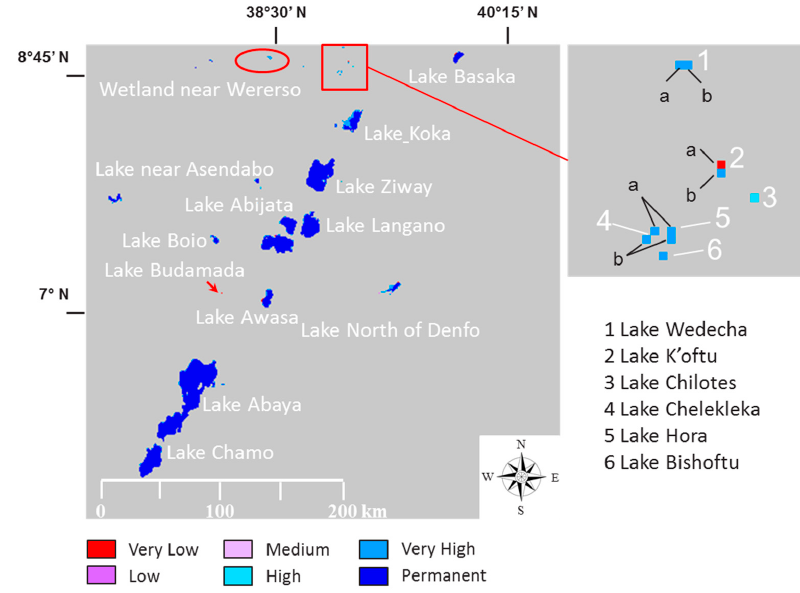
Figure 11. The Water Body Occurrence (WBO) for part of image MC10_20131201 taken over Rift Valley in Ethiopia (center: 7°11 ′ 31 ′′ N, 38°51 ′ 10 ′′ E).